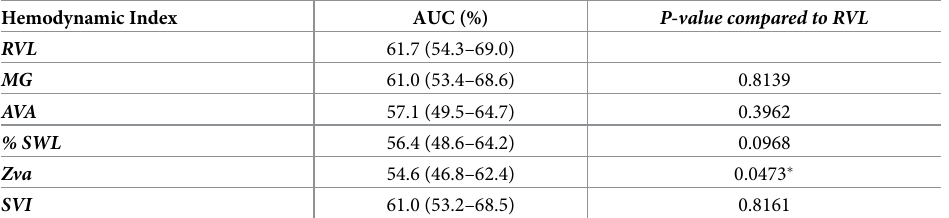
AUC: Area under the curve; AVA: Aortic valve area; MG: Mean pressure gradient; RVL: Relative valve load;